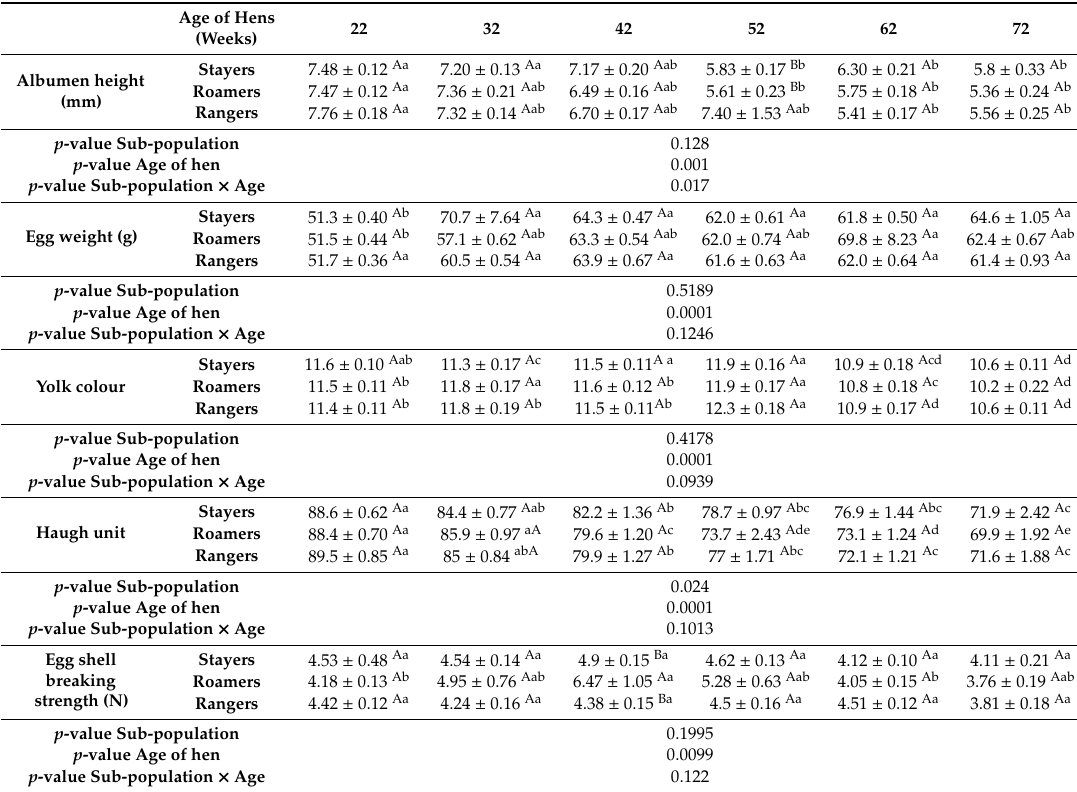
Table 2. The di ff erence between the egg quality of stayers, roamers and rangers at 22, 32, 42, 52, 62 and 72 weeks of